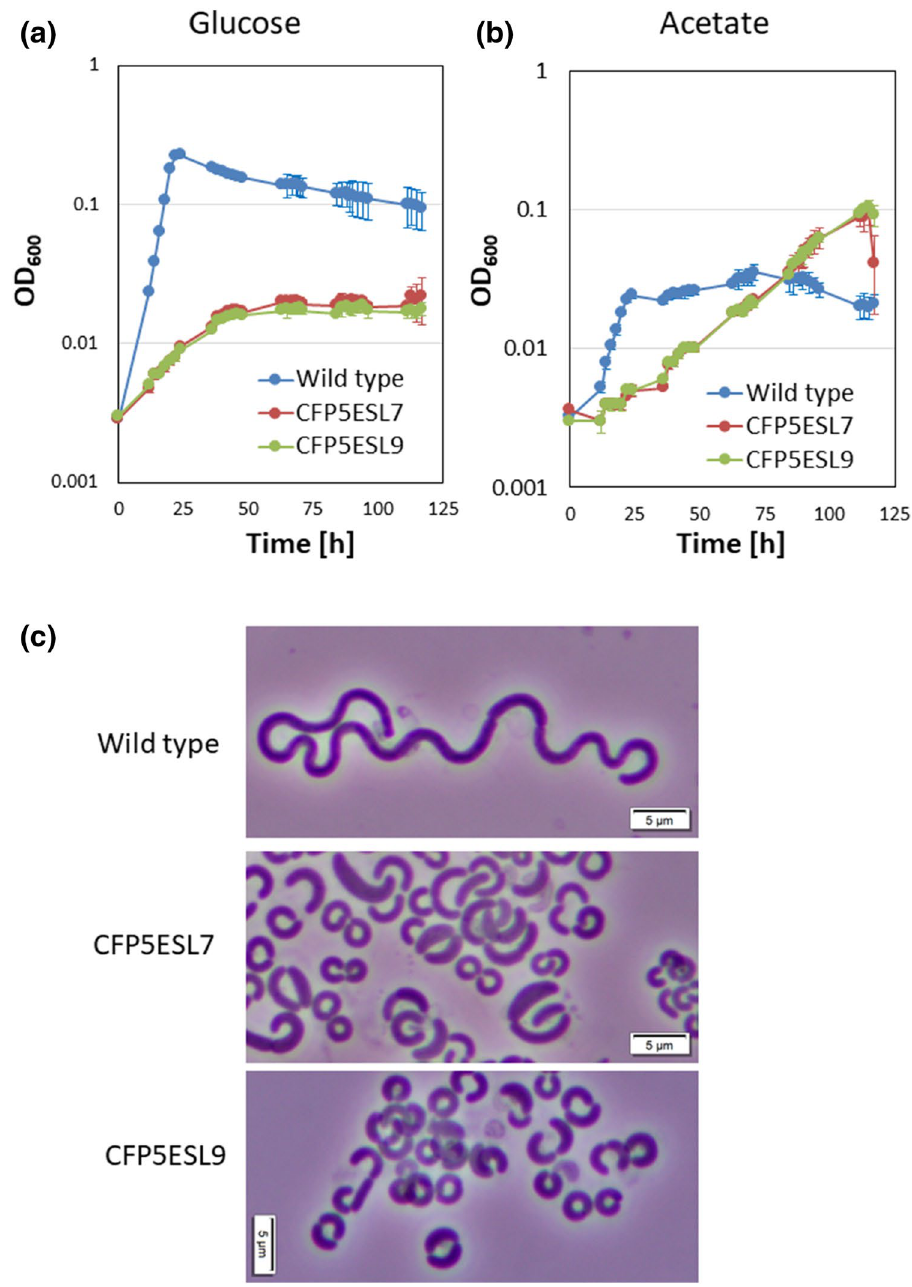
Figure 4. Growth of wild-type and cefoperazone-resistant clones carrying PDHc-deficient mutations. ( a , b ) Growth of the wild-type (ATCC33905) and cefoperazone-resistant clones (CFP5ESL7 carrying Slin_5165 encoding the PDHc transketolase central region and CFP5ESL9 carrying only one mutation in Slin_5509 encoding PDH E1 α subunit) are shown. Blue: wild type, red: CFP5ESL7, green: CFP5ESL9. Cells were grown on Spirosoma medium containing either 0.1% (wt vol -1 ) glucose ( a ) or 0.1% acetate ( b ) at 26 °C with shaking. Growth was monitored by measuring OD 600 . Each growth measurement was performed three times, starting from independent cultures. Error bars represent standard deviation. ( c ) Microscopy of the wild-type, CFP5ESL7, and CFP5ESL9 strains grown on Spirosoma medium supplemented with 0.1% acetate at 26 °C with shaking are shown. Bar, 5